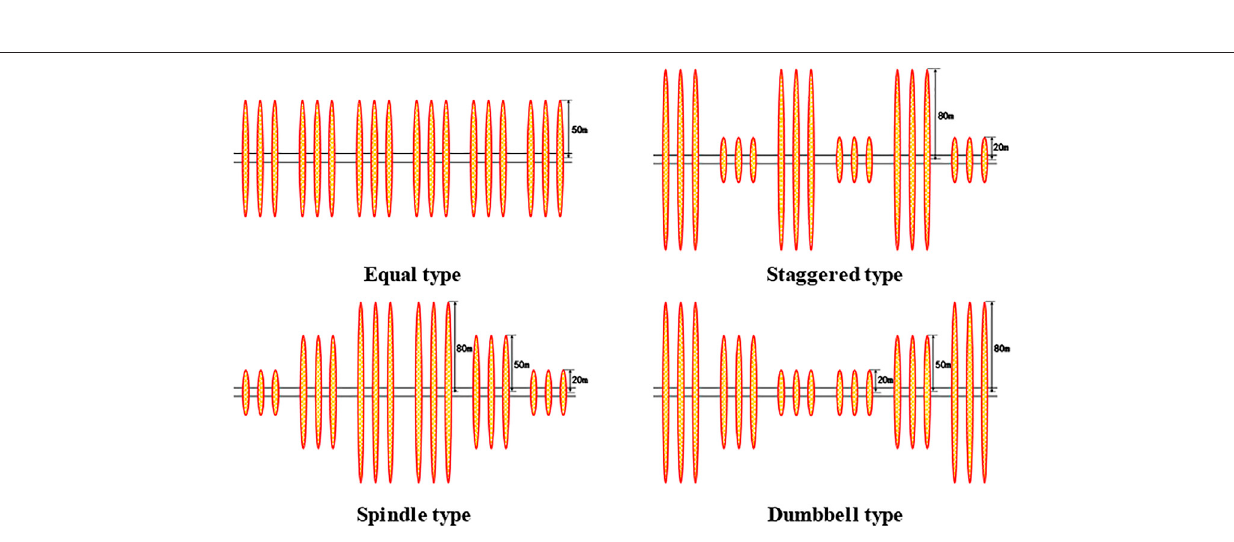
FIGURE 11 | Different fracture laying